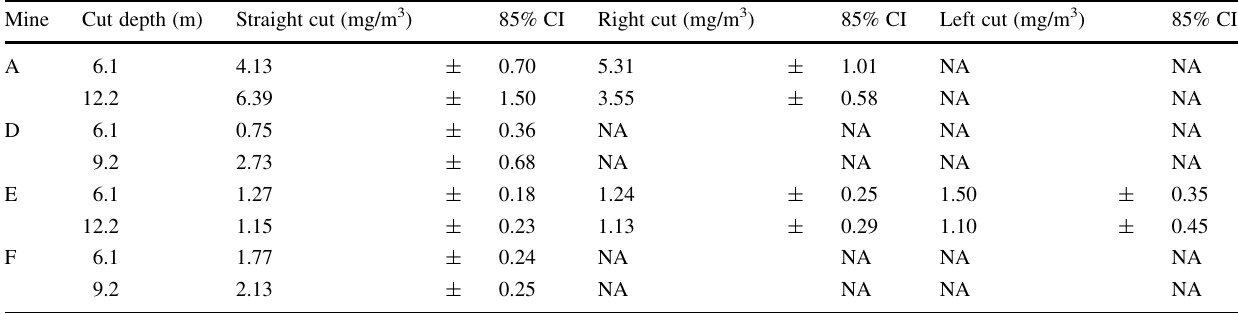
Table 1 Average coal mine respirable dust concentrations with 85% confidence intervals, measured at the location of shuttle car operators when the continuous miner cuts and loads cars (Potts et al. 2011) Mine Cut depth